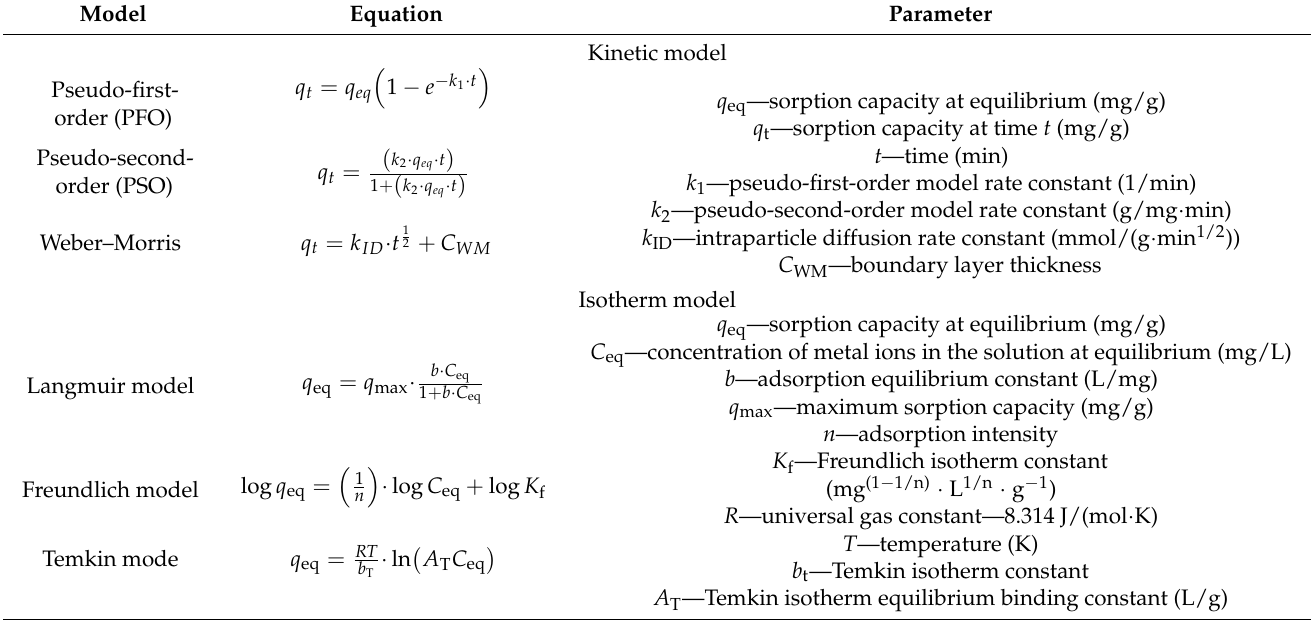
Table 1. Kinetic and equilibrium sorption models used in the present